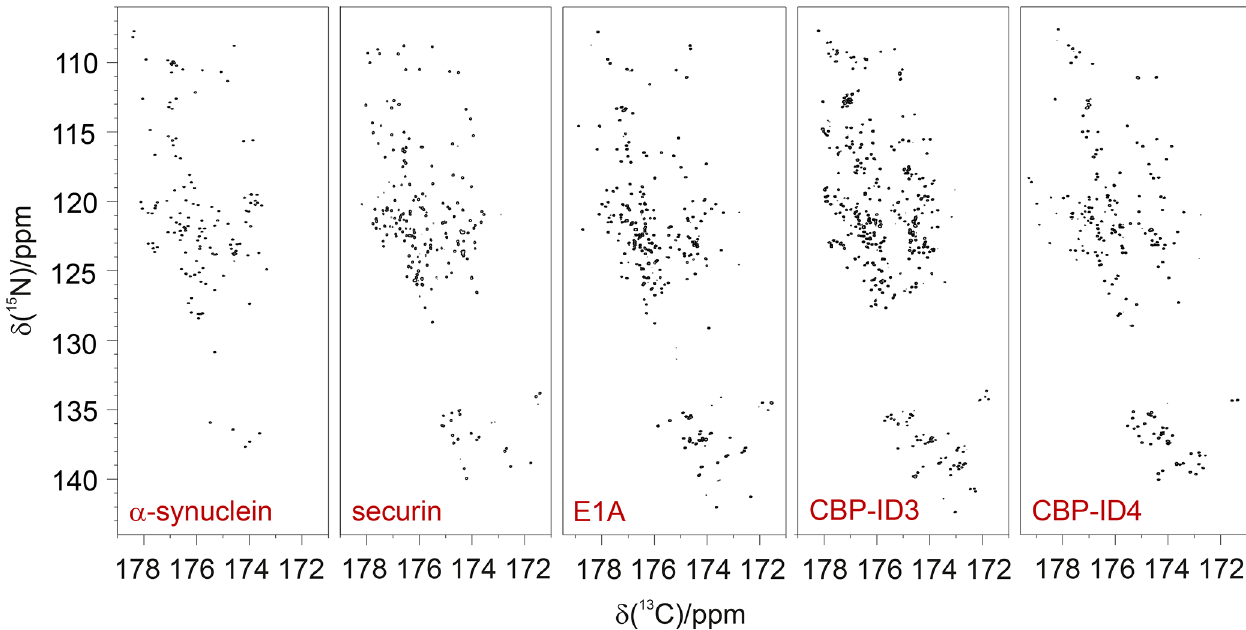
Figure 1. Proline residues are abundant in IDPs/IDRs, and their 15 N resonances can be easily detected. They fall in a specific, isolated region of the 2D CON spectrum, as illustrated by the examples in the figure. From left to right: α -synuclein (140aa, 4% Pro; Bermel et al., 2006b), human securin (200aa, 11% Pro; Bermel et al., 2009), E1A (243aa, 16% Pro; Hošek et al., 2016), CBP-ID3 (407aa 18% Pro; Contreras-Martos et al., 2017), and CBP-ID4 (207aa, 22% Pro; Piai et al.,